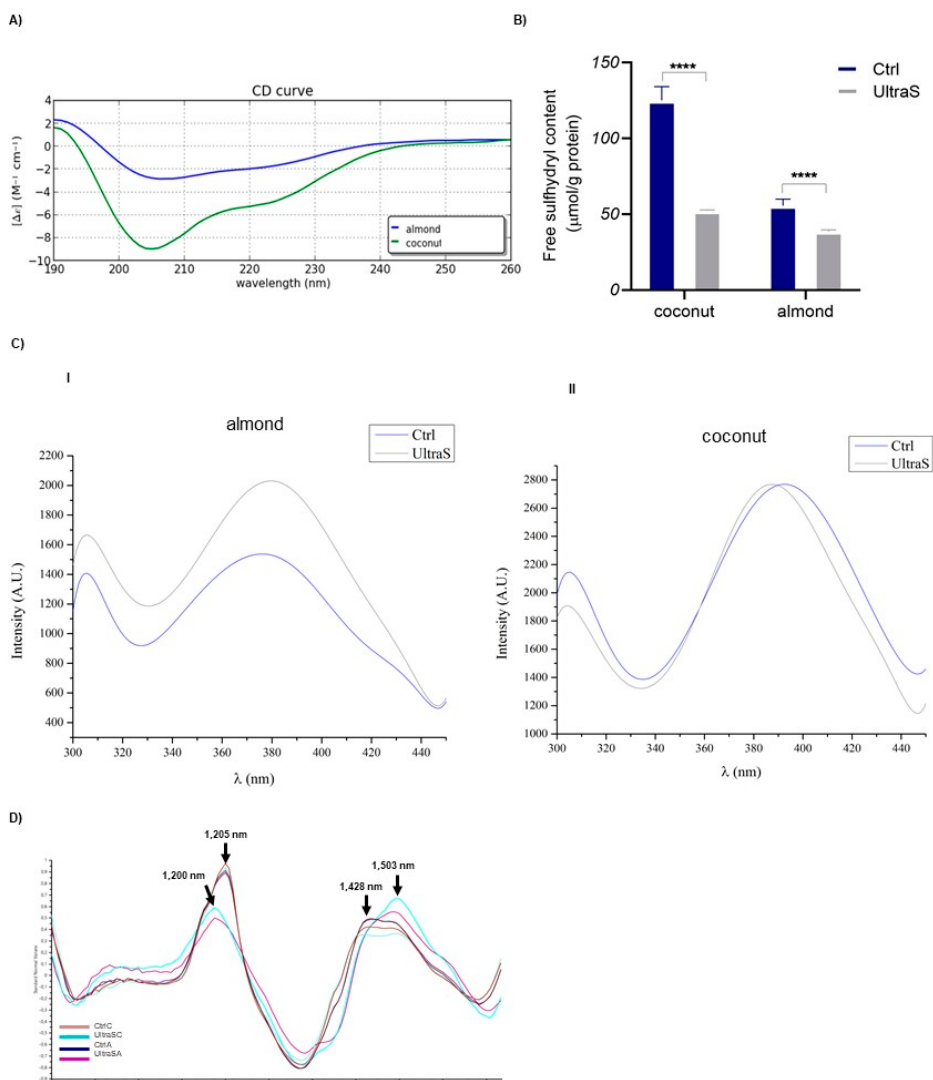
Figure 3. ( A ) CD spectra of almond and coconut UltraS; ( B ) free SH content in UltraSC and UltraSA, CtrlC and CtrlA, (****) p < 0.0001.; ( C ) intrinsic fluorescence signal detection of almond ( I ), and coconut ( II ); ( D ) micro-NIR spectra expressed as standard normal variate